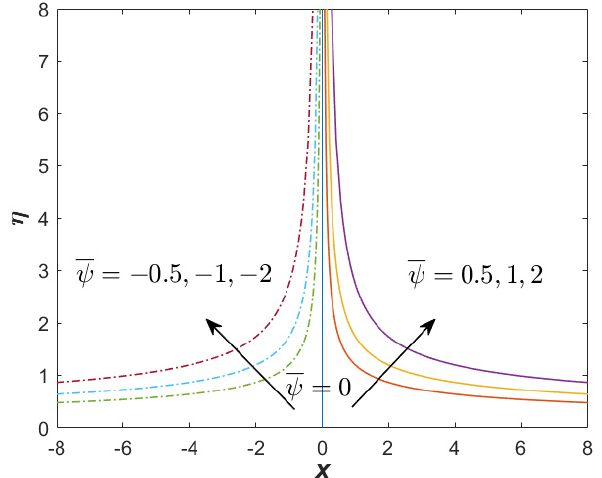
Figure 6. − θ (cid:48) ( 0 ) for various α (acceleration parameter). ( ) 0 θ ′− for various α (acceleration parameter). Figure 6.